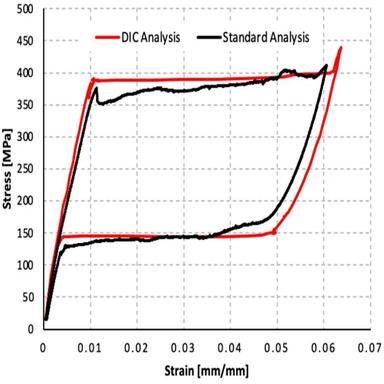
Stress–strain map determined with the standard and DIC approaches described in the article.